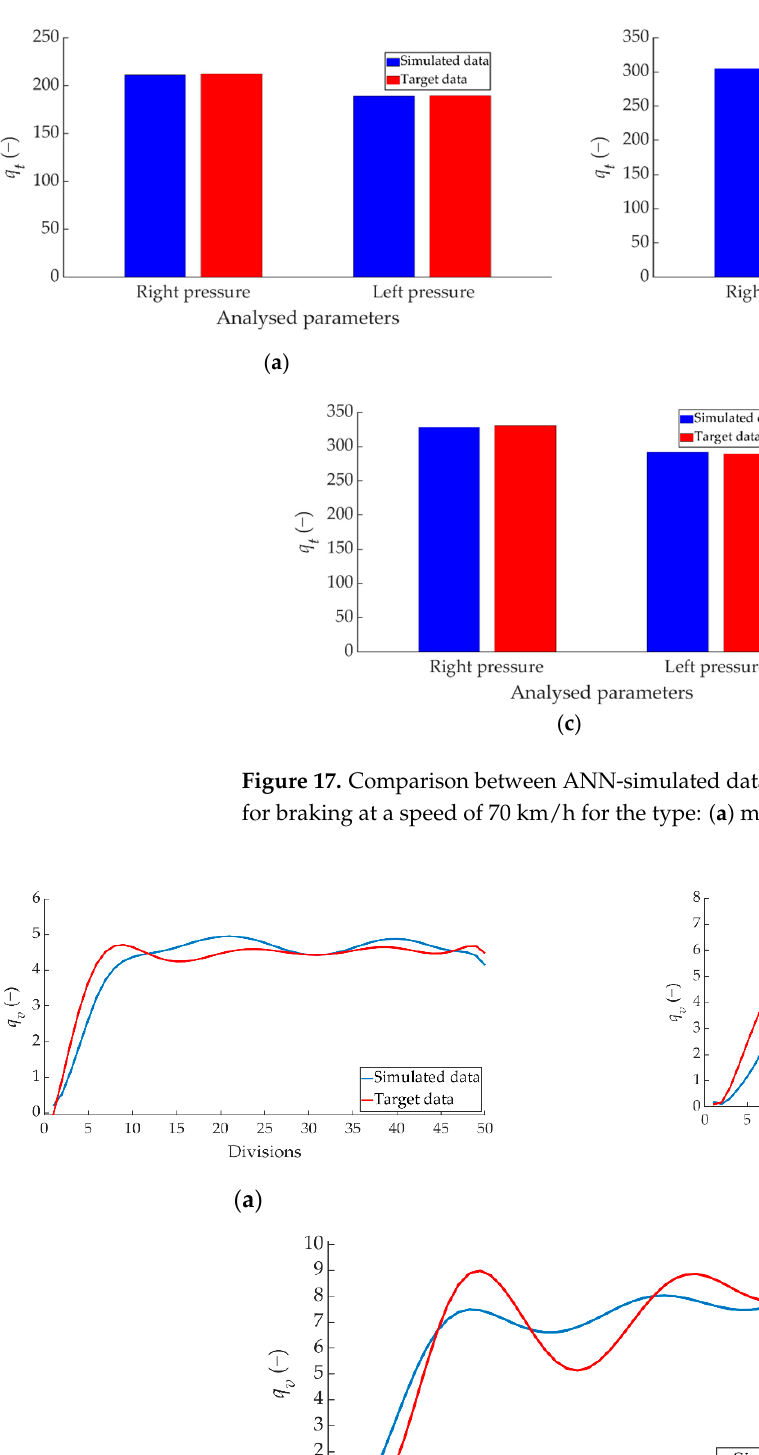
rately. Figure 17 compares the simulation of the ANN estimated values and the target data for the braking capacity ( q t ) for the two pressure sensors (right and left).